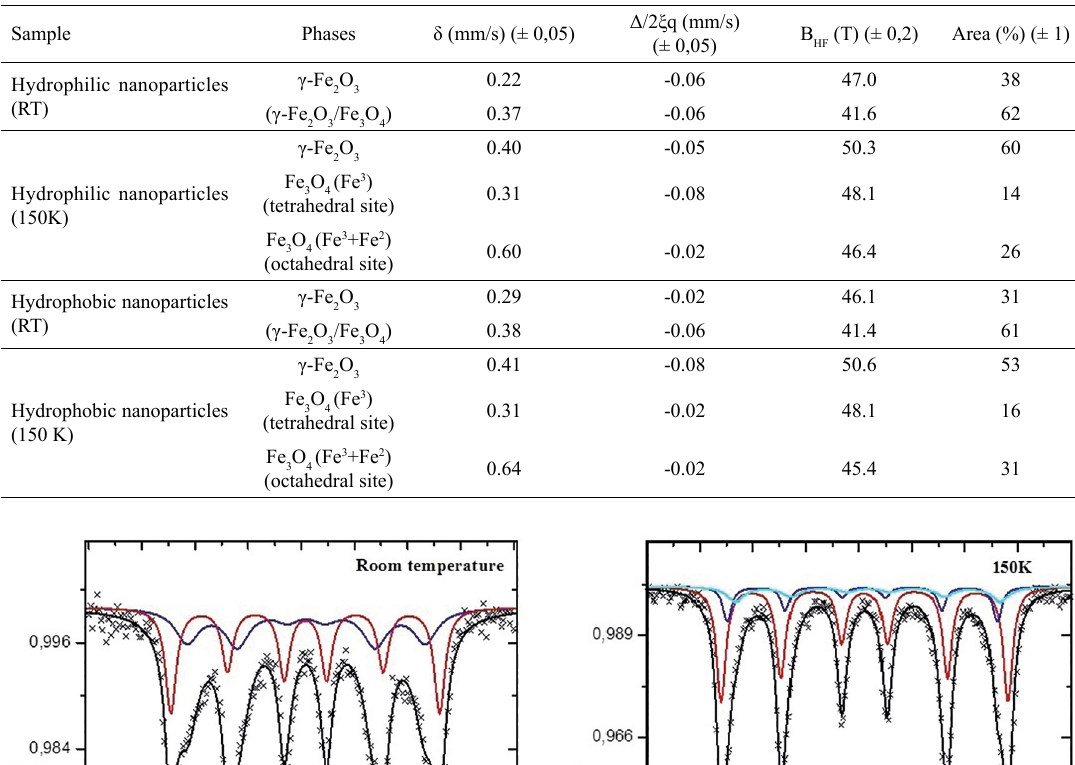
Table 2: Mössbauer parameters for hydrophilic and hydrophobic magnetic nanoparticles at room temperature and 150K. Sample